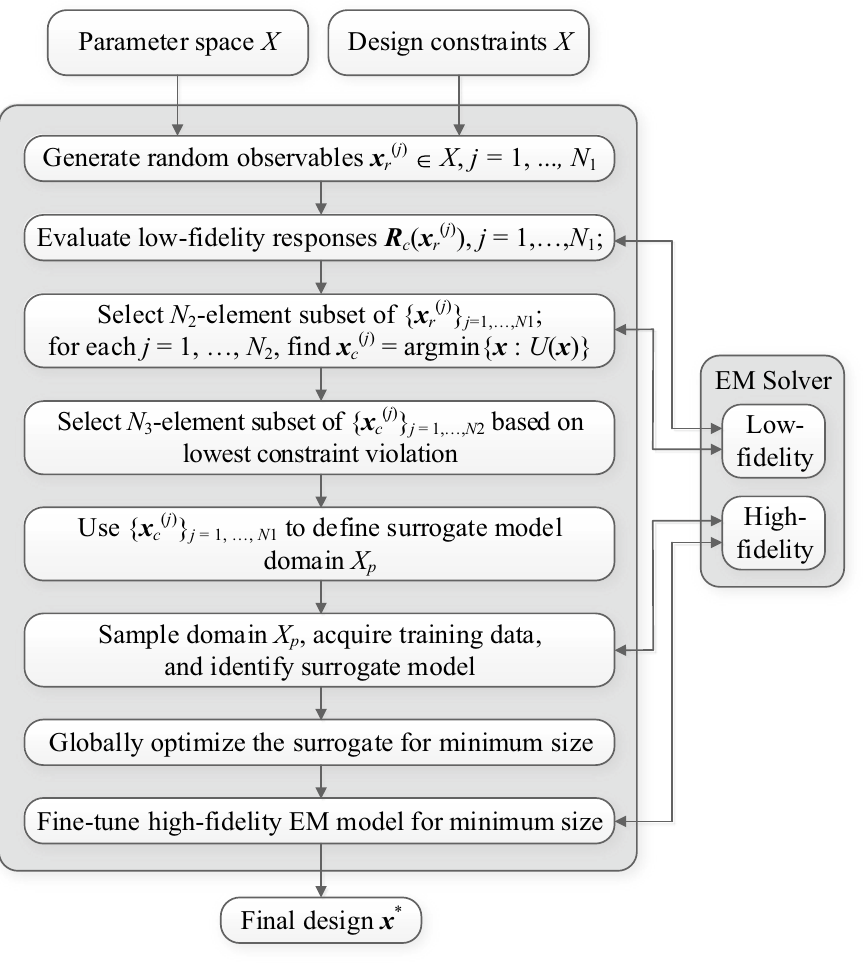
Figure 8. Flow diagram of the proposed globalized size reduction framework.